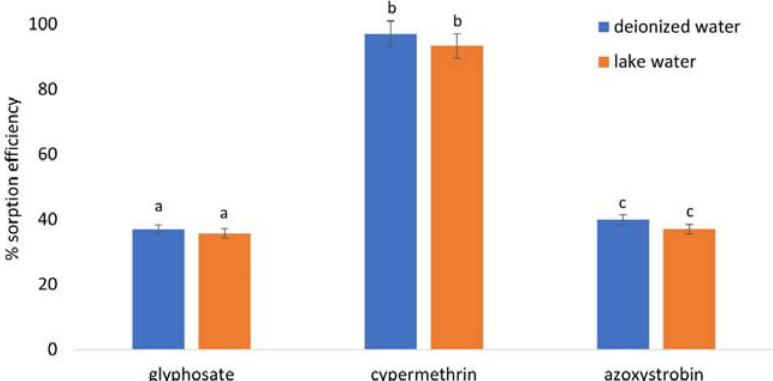
Figure 7. % Sorption efficiency of the glyphosate (using 2000 ppm FA), cypermethrin (using 2000 ppm HA), and azoxystrobin (using 2000 ppm HA) from deionized and lake water; bars represent the average sorption efficiency of five replicate analyses. Statistically significant differences ( p < 0.05) are depicted with small letters.